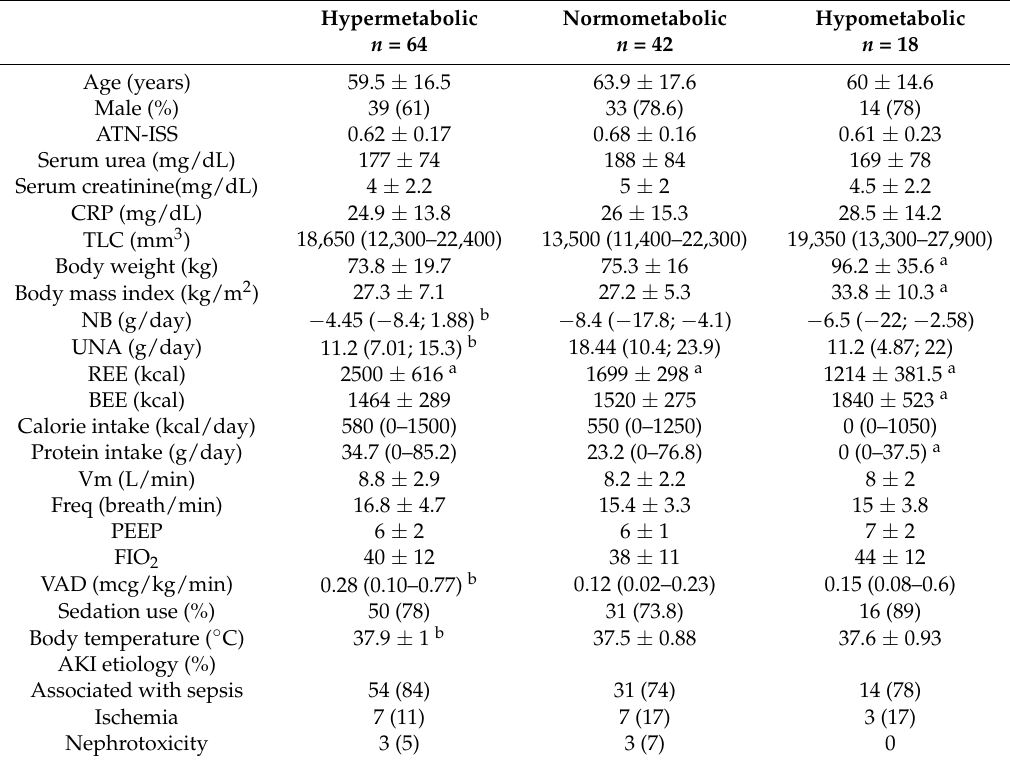
Table 2. Characteristics of severe AKI patients divided by categorization of